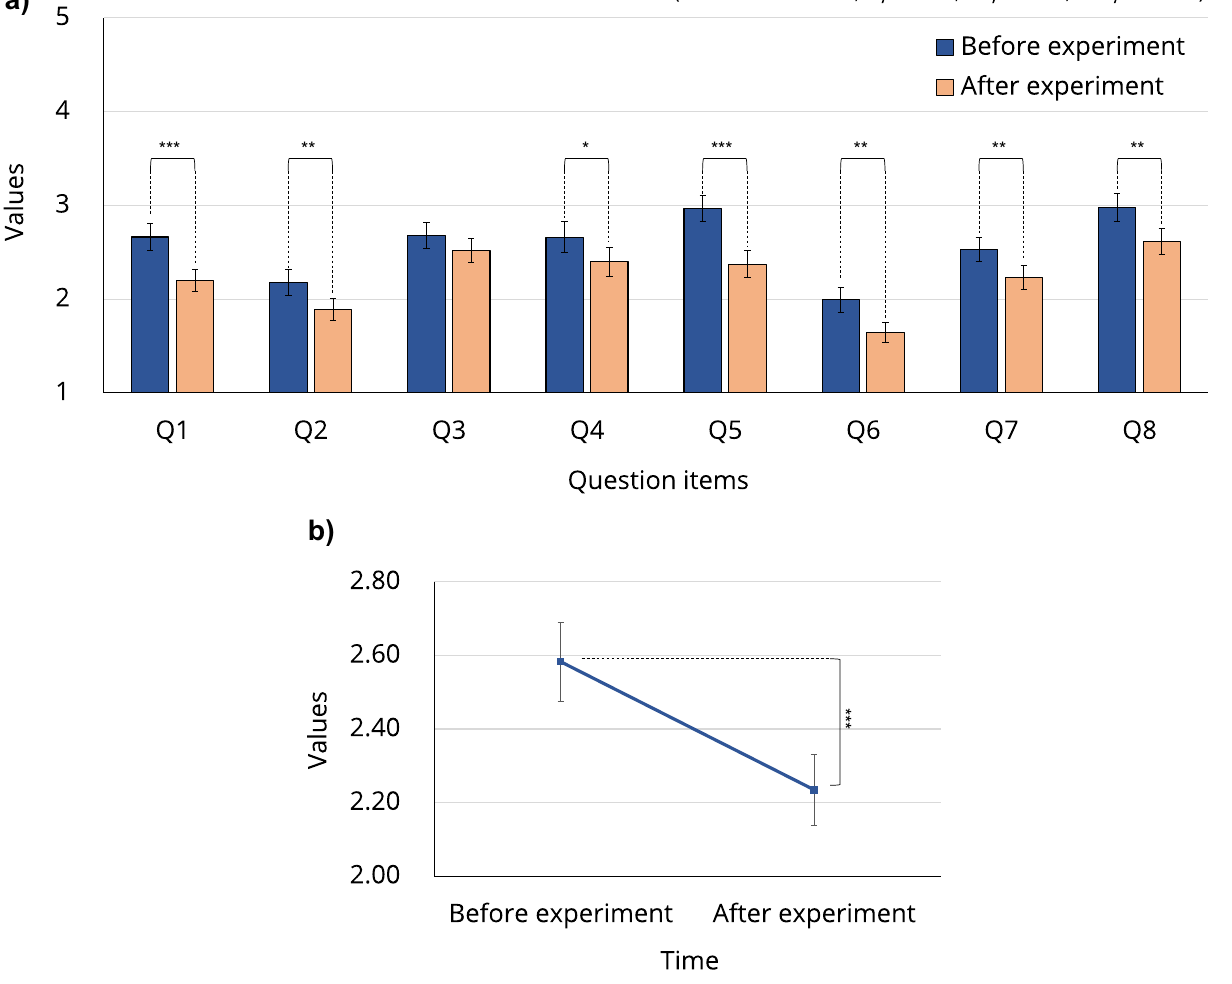
Figure 5. Participants’ fear of injections before and after the experiment. ( a ) Q1–Q8 asked participants’ fear for eight different scenarios related to injections (see Supplementary Table S4 for descriptions of these scenarios). ( b ) The average score for the eight questions before and after the experiment. The post hoc comparison revealed a significant decrease in the average score ( p < 0.001 ) after the